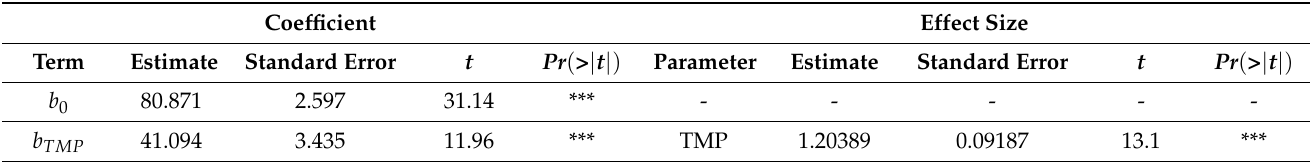
Table 8. Parameter estimates of the significant parameters, and effect size estimate of the significant parameter of the objective function.